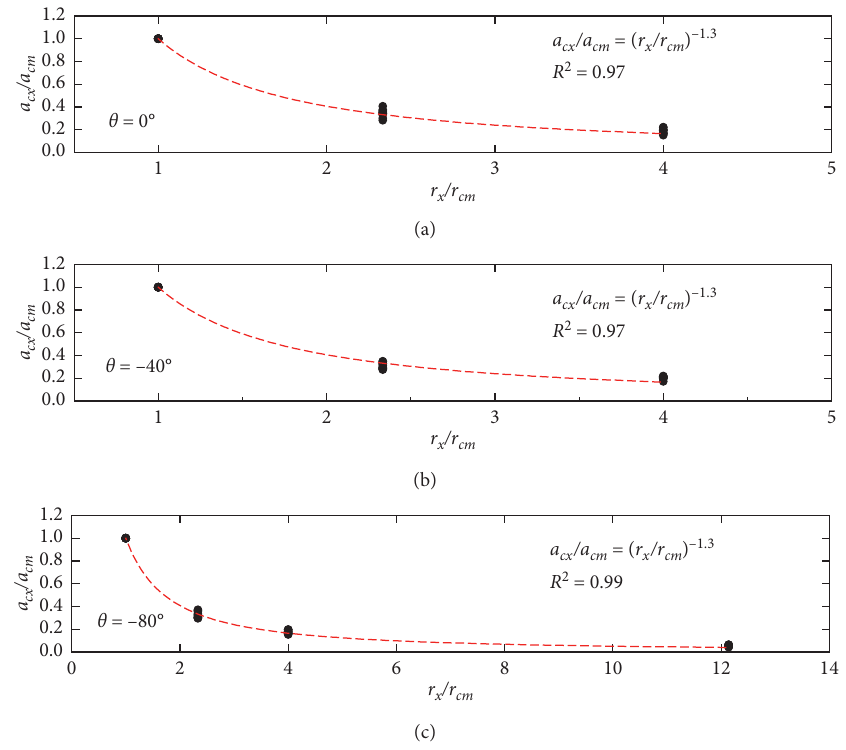
Figure 11: The attenuation law wave crest amplitude in straight reach.